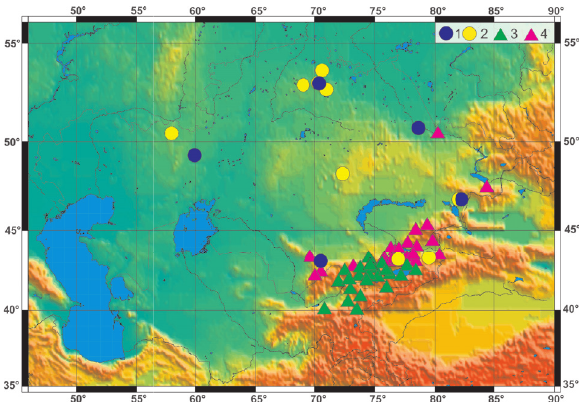
Figure 5. Map of the seismic stations used to address inconsisten- cies in the sources considered to compile EMCA catalogue between 1991 and 2009 A.D. See text for details. The legend reports: (1) seis- mic arrays of the IGR; (2) three-component stations of the IGR; (3) three-component stations of KNET and EMSE networks of Kyr- gyzstan; (4) three-component stations of SEME